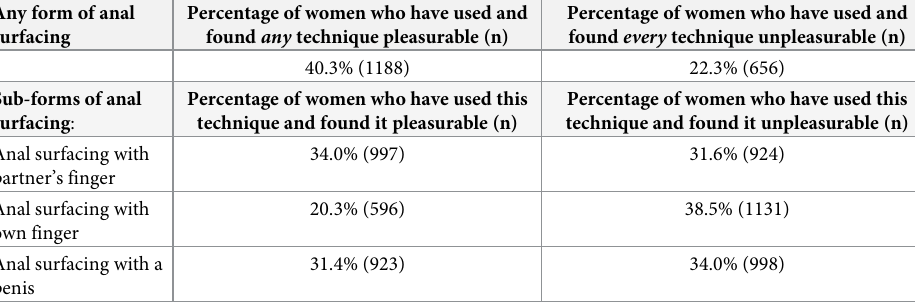
Table 2. Prevalence of anal surfacing techniques women find pleasurable (N = 2937, weighted). Any form of anal Percentage of women who have used and surfacing found any technique pleasurable (n)